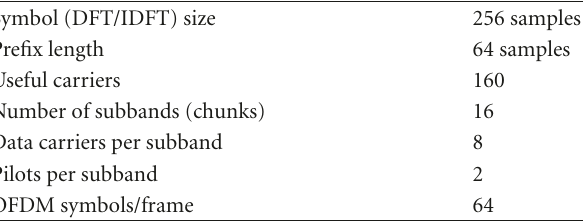
Table 6: OFDMA Parameters in